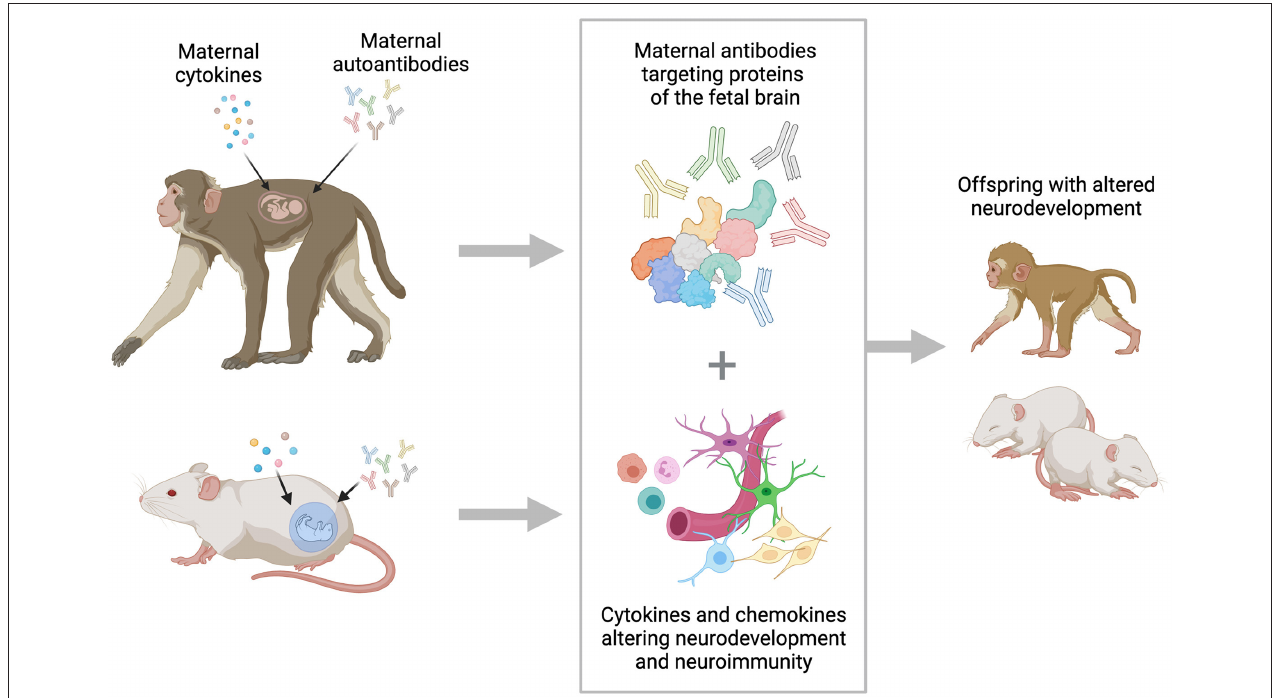
FIGURE 1 | Schematic of maternal cytokines and autoantibodies affecting fetal brain development as studied using animal models. Dysregulation of maternal immune system is a strong risk factor for the development of ASD. Alterations in the production of maternal cytokines and chemokines can impact the neurodevelopmental process, and the presence of maternal autoantibodies reactive to critical proteins can alter how the developmental trajectory of the brain. Pre-clinical models are used to better understand the underlying mechanisms for both proposed pathways to altered neurodevelopment. The figure was generated by Biorender